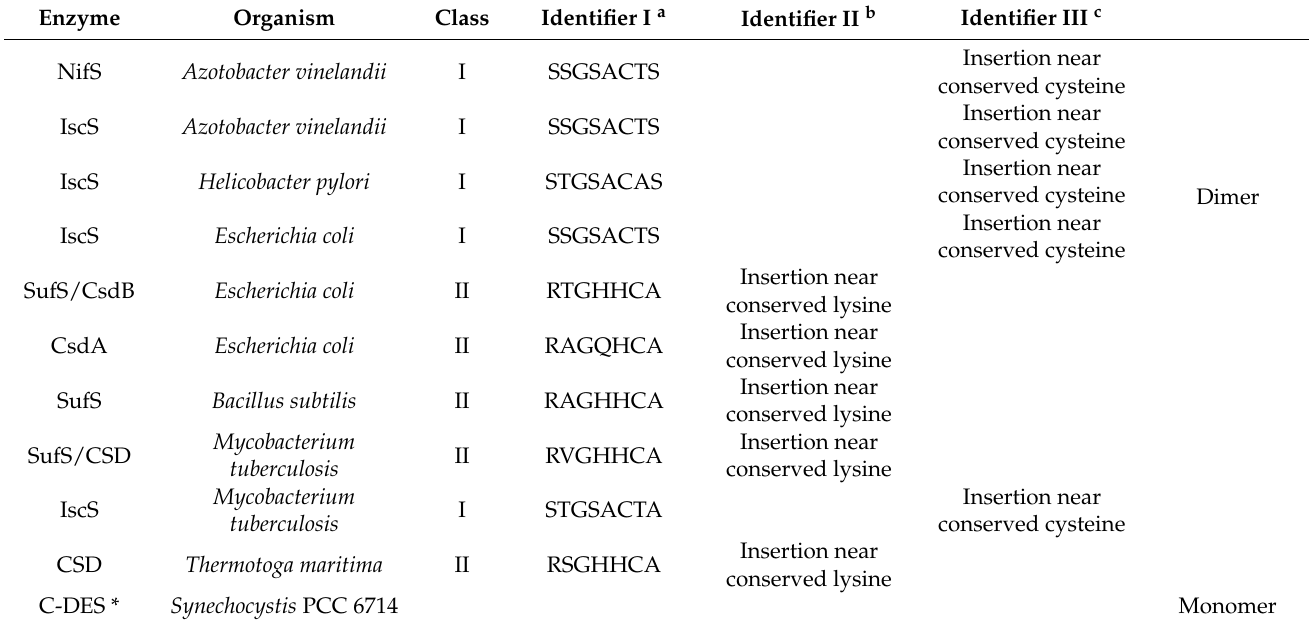
Table 1. Classification of CSDs based on primary amino acid